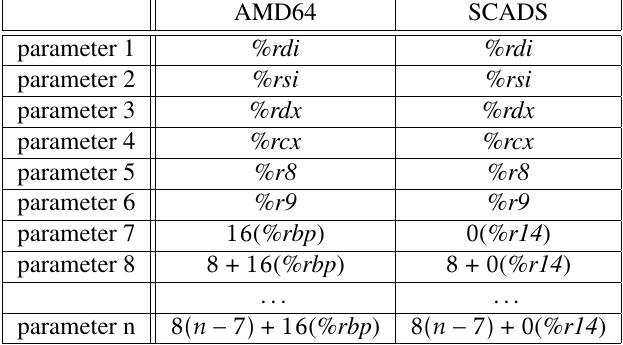
Table 5. Table listing the (integer) parameter passing according to the AMD64 ABI [3] and the SCADS ABI with frame pointer in use.